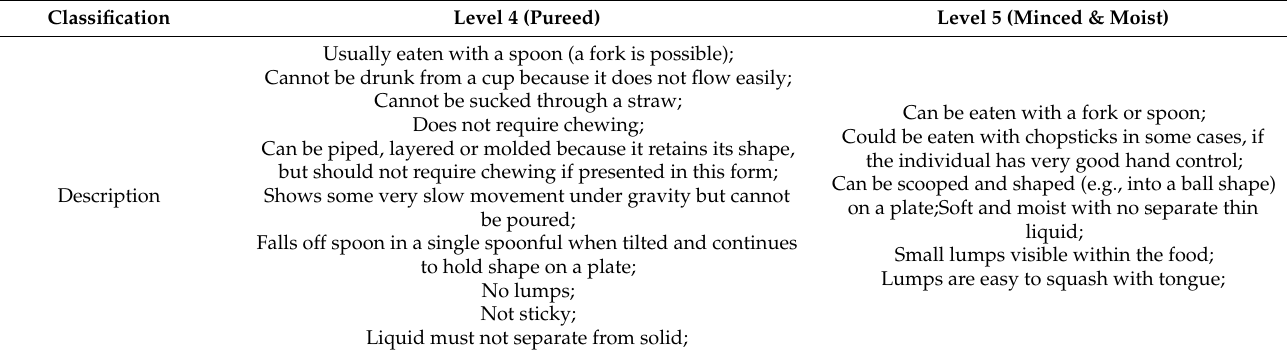
Table 1. Description of characteristics of dysphagia diets of level 4 and 5. Classification Level 4 (Pureed) Level 5 (Minced & Moist)